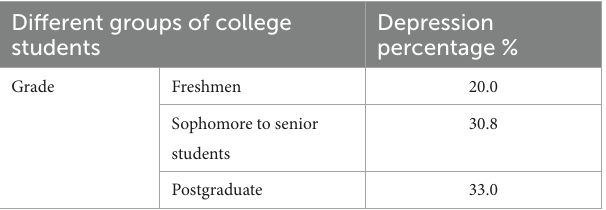
TABLE 4 The comparison of depression prevalence among different groups. Different groups of college